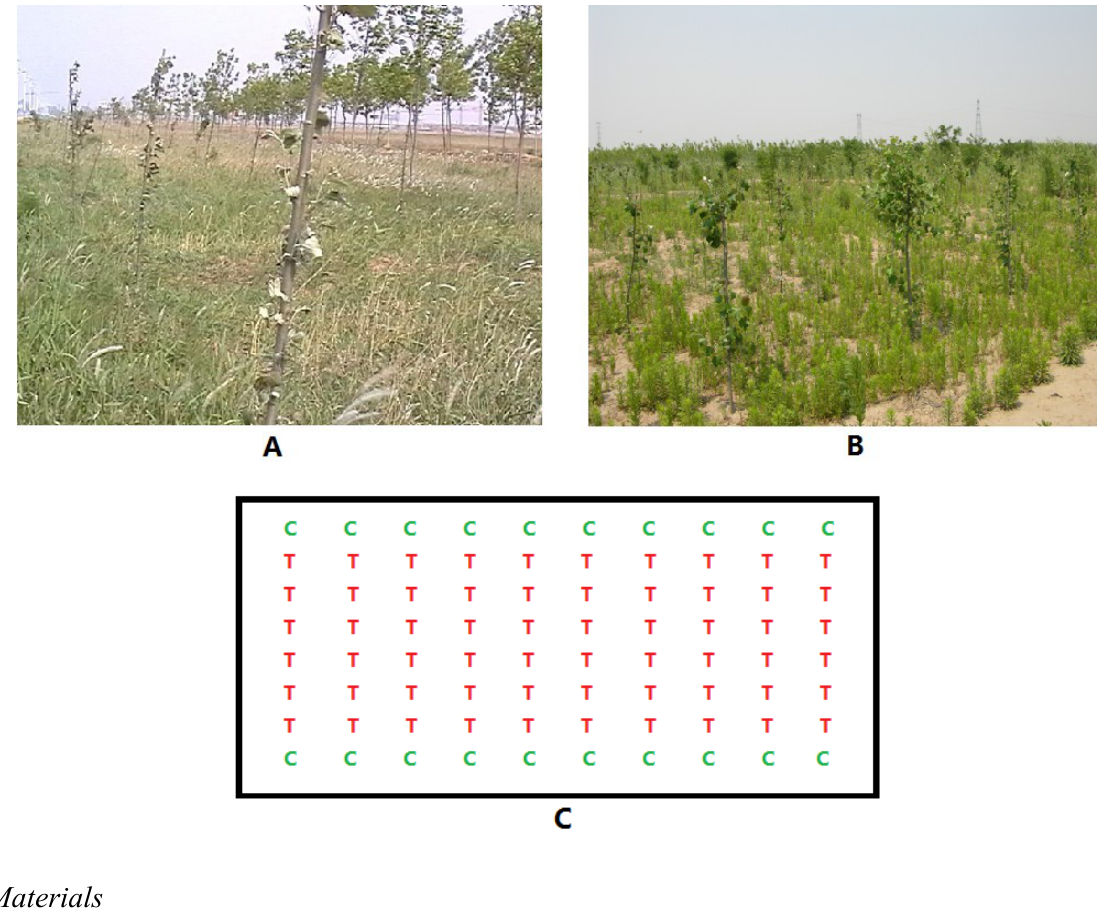
Figure 2. Images of the trial field in 2005 (A and B ). ( C ) The layout of the field. C, non-transgenic control; T, transgenic poplar. The spacing within the rows was 3 m; the spacing between rows was 4